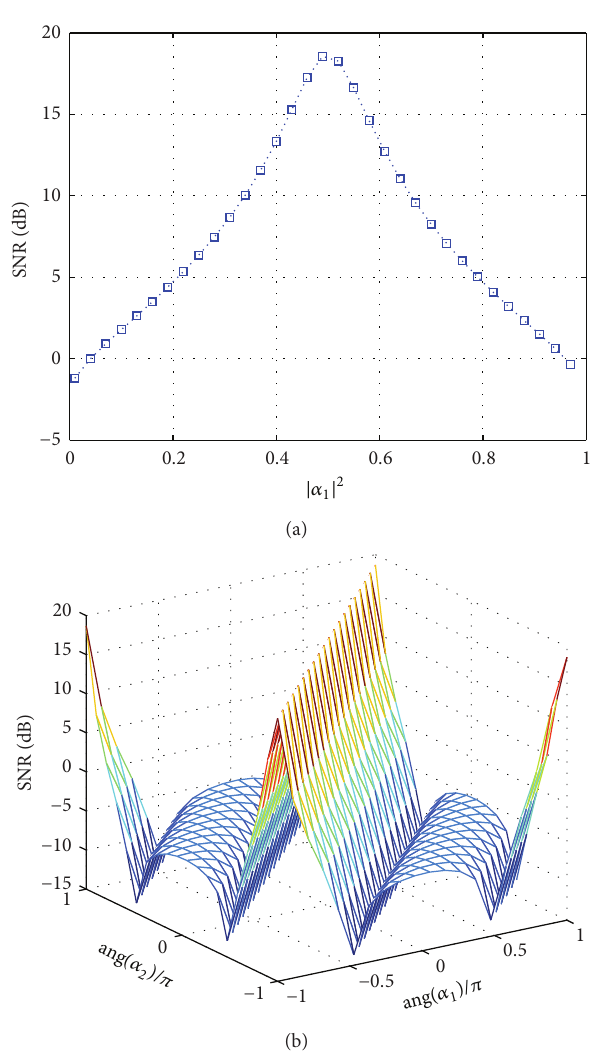
Figure 5: (a) The intensity of the scattering coefficient of the first target versus the resolution threshold (ang (𝛼 1 ) = ang (𝛼 2 ) = 0 ). (b) Thephasesofthetwoscatteringcoefficientsversustheresolution threshold ( |𝛼 1 | 2 = |𝛼 2 | 2 = 0.5